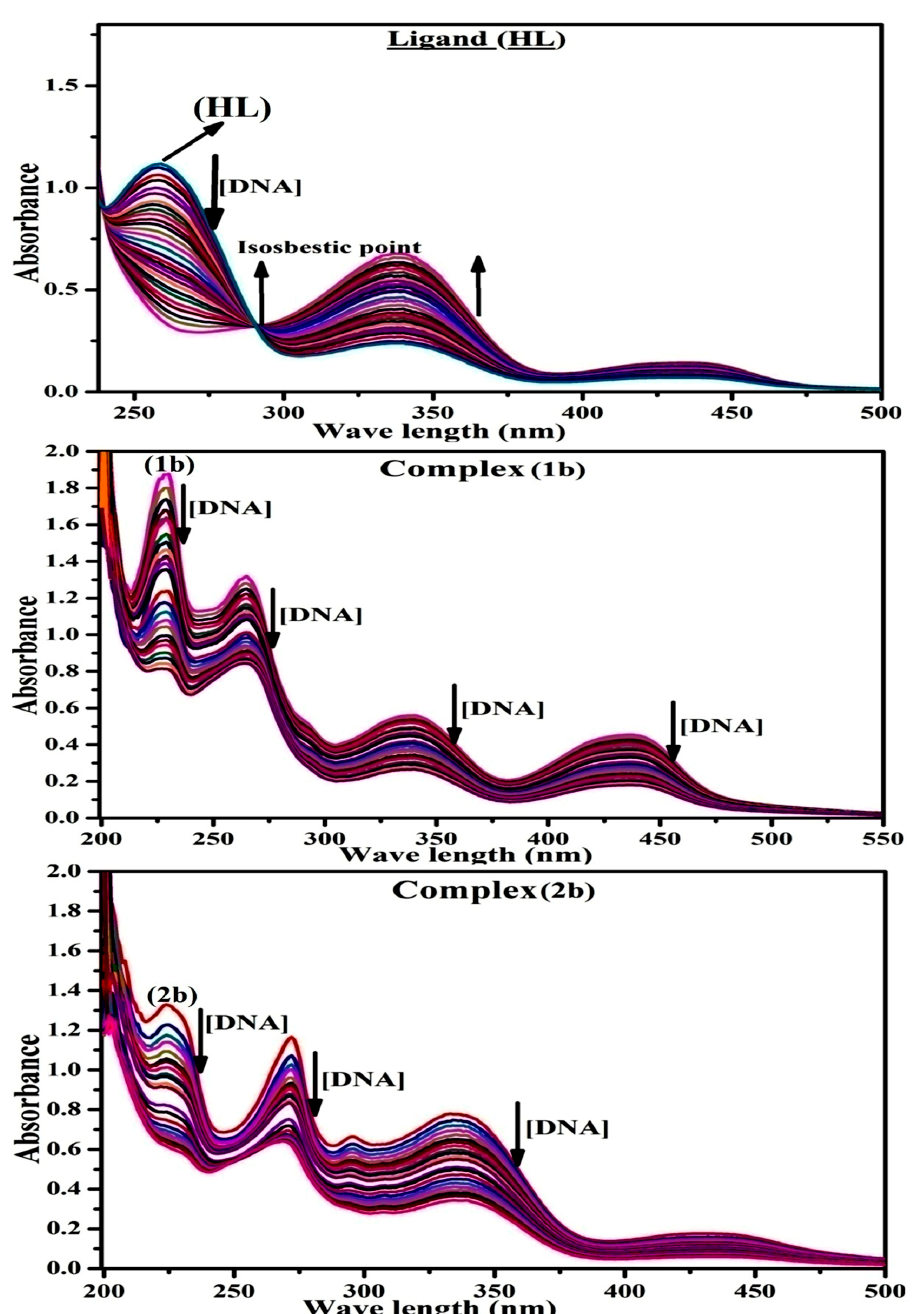
Figure 3. The absorption spectra of ligand ( HL ) and its complexes ( 1b – 2b ) in Tris-HCl buffer pH = 7.2 at 25 °C in the presence of increasing amount of CT-DNA. The arrow indicates the changes in absorbance upon increasing the CT-DNA concentration and another arrow shows isosbestic points indicates that equilibrium is established between DNA and complexes.